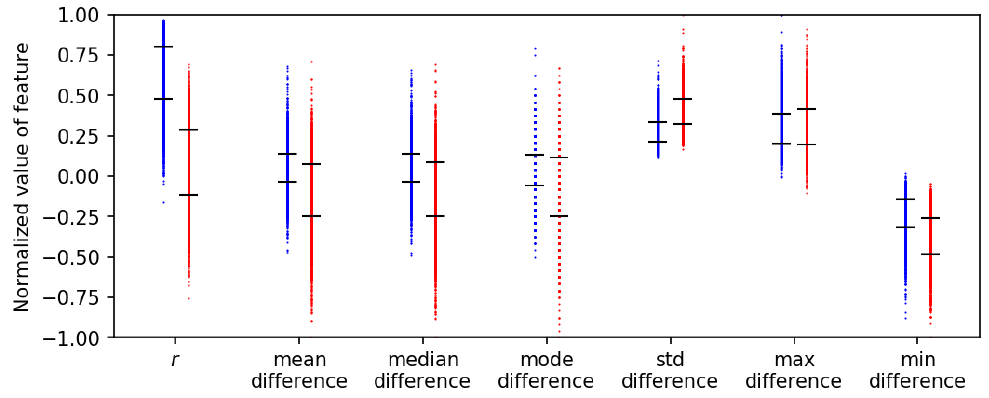
Figure 7. Parallel coordinate plot of seven normalized features. Red and blue marks denote samples classified as collapsed and non-collapsed buildings, respectively. The black ticks delimit the range of [ average − std , average + std ] for each normalized